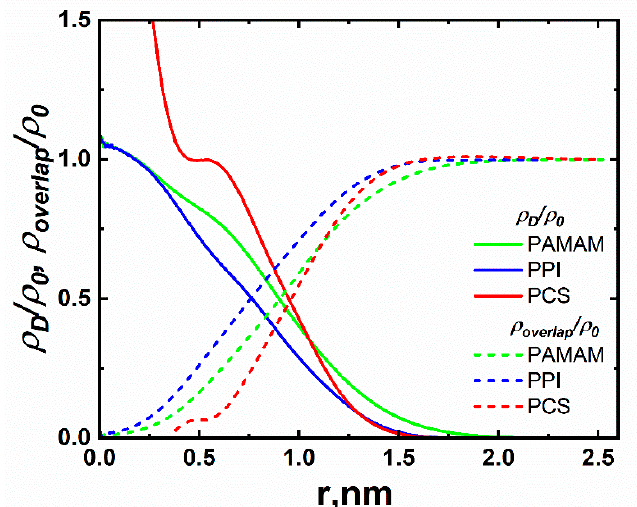
Figure 4. The radial density profiles from the center of mass of the macromolecule both for selected dendrimer, ρ D , (solid) and for the rest of the dendrimers in the system, ρ overlap , (dashed) using the formula: ρ ( r ) = < m ( r ) > / V ( r ) , where ρ ( r ) is the average density in the spherical layer at a distance r from the dendrimer’s center of mass, < m ( r )> is the average total mass of atoms in the layer of volume V ( r